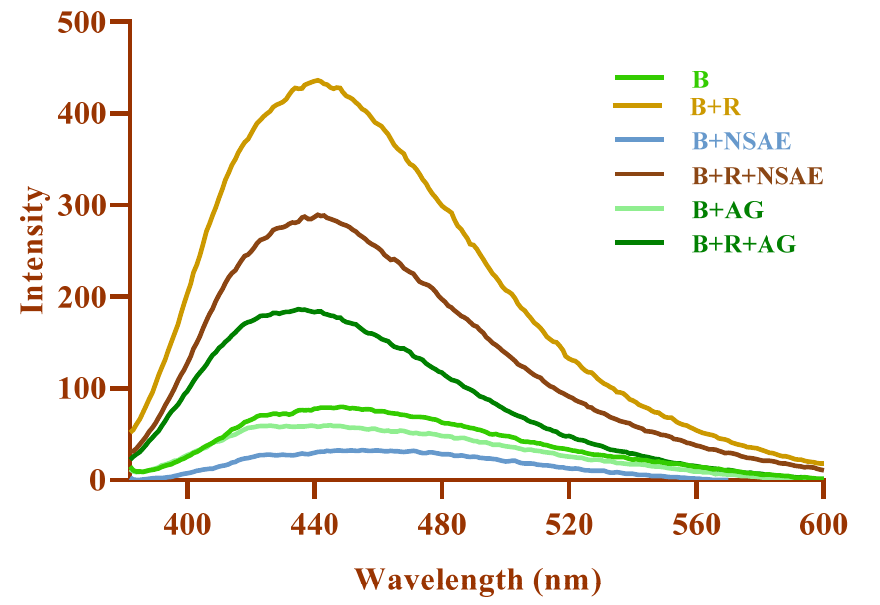
Figure 8. The effects of Nigella sativa aqueous extract (NSAE) on fluorescent AGEs formation in BSA+D-ribose system.